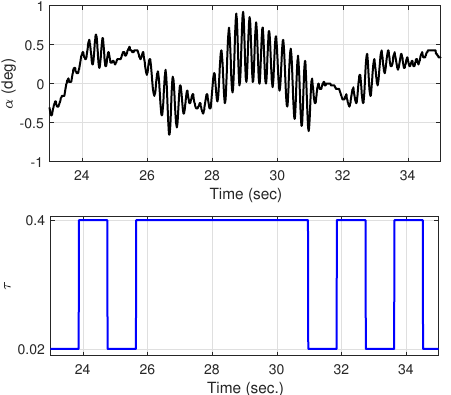
Figure 5. Experimental results in the time interval [23, 35] s. It can be appreciated that when the time delay is about 0.4 s, the pendulum maintains its upright position.